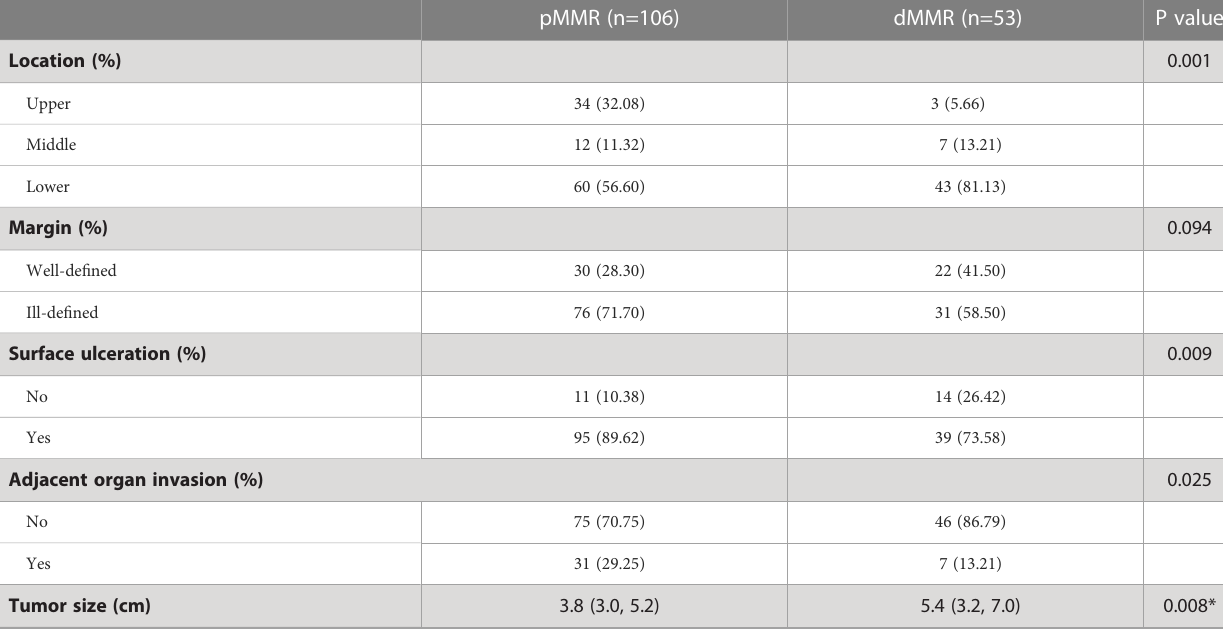
TABLE 2 Comparison of CT features between dMMR and pMMR GC patients.